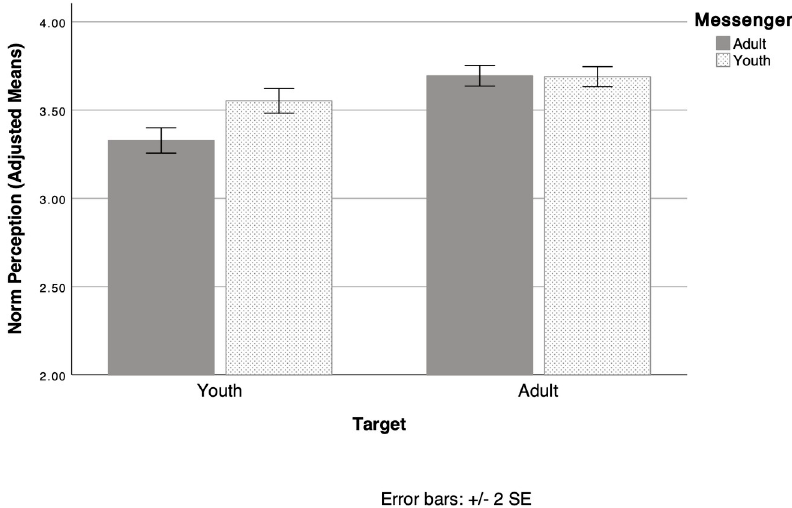
Fig 2. Interaction between messenger and norm perceptions for youth vs adults. Those exposed to child messengers saw youth action on environmental issues as significantly more normative than those exposed to adult messengers. (All means adjusted to control for CNS and political orientation. Error bars represent +/- 2